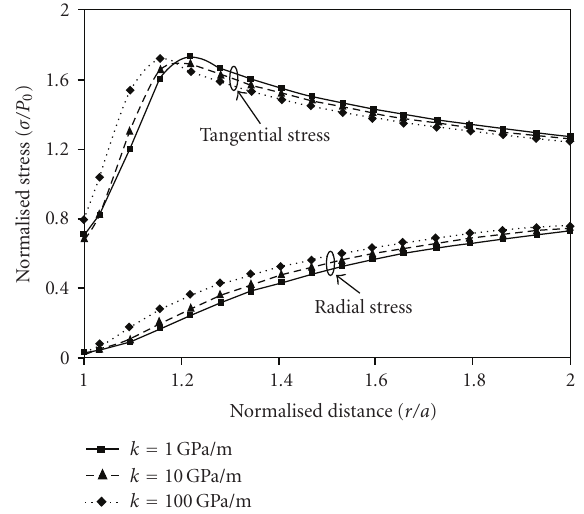
Figure 14: Performance of bolt with varying shear sti ff ness (with